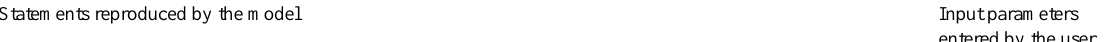
Table 2. Input parameters used to reproduce the second case study. Left column represents the statements reproduced by the model. Right column represents the input